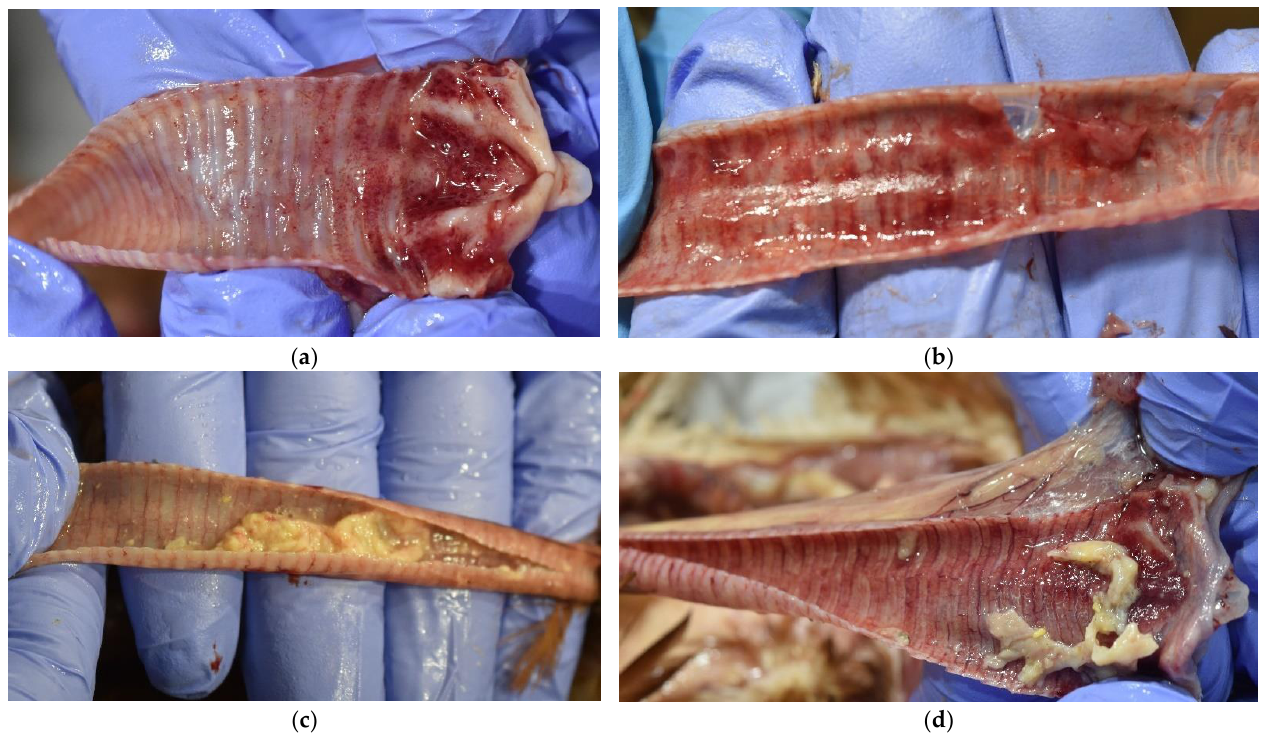
Figure 3. ( a , b ) Inflammation of the mucous membranes of the larynx and trachea—hemorrhagic exudate; ( c , d ) yellow caseous plaques in the lumen of the